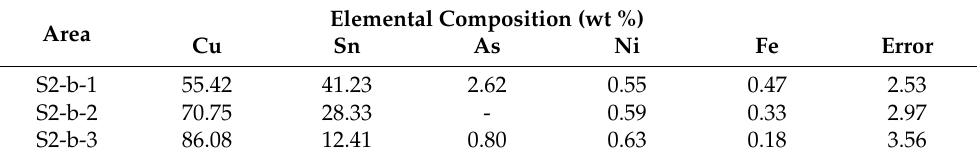
Table 4. Elemental chemical composition of the ornamental layer surface towards the interface.